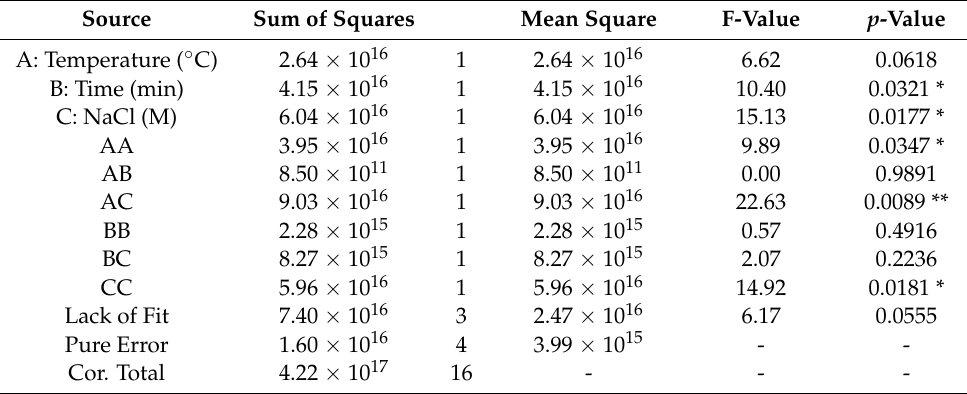
Table 4. Analysis of variance (ANOVA) for the quadratic model of volatiles extraction. Source Sum of